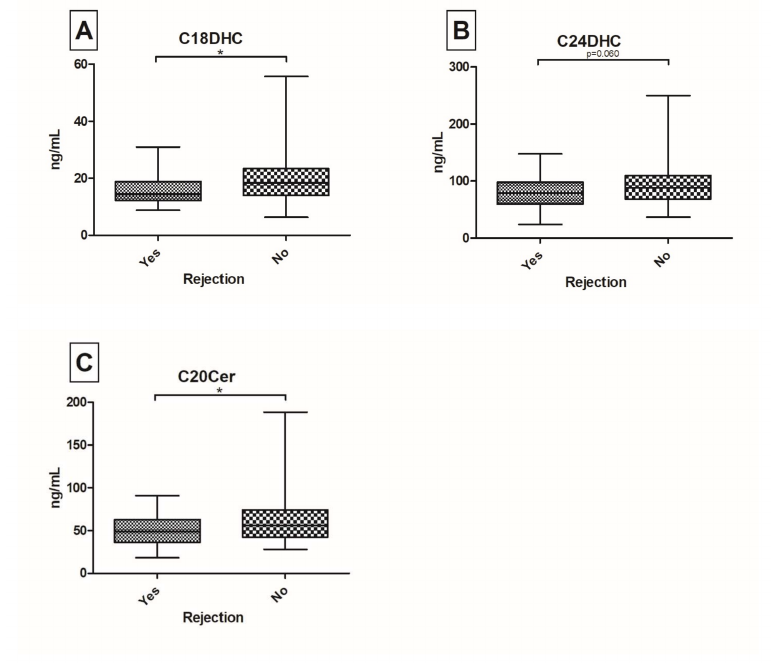
Figure 1. Serum ceramides (Cer) and dihydro-ceramides (DHC) in post-OLT patients with history of graft rejection. C18DHC ( A ), C24DHC ( B ) and C20Cer ( C ) are down-regulated in patients with graft rejection (* p <